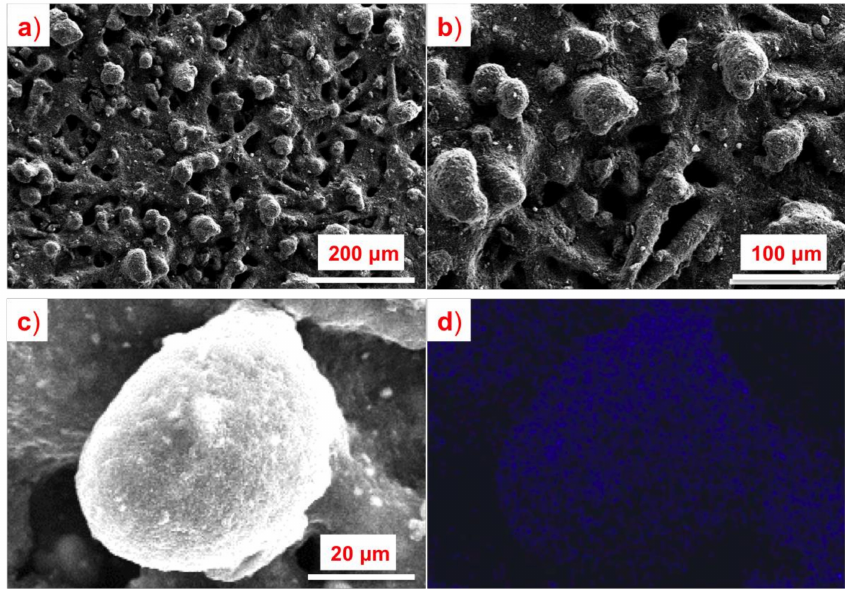
Figure 5. ( a , b ) Scanning electron microscope (SEM) images of the cathode gas diffusion electrode (GDE) with a CF-VC catalyst and a poly(ethylenetetrafluoroethylene) (ETFE) powder deposited onto Toray-60 carbon paper under different magnifications; ( c ) SEM images showing that the ETFE ionomer was wrapped by the CF-VC; ( d ) corresponding fluorine mapping of the image in ( c ) showing the